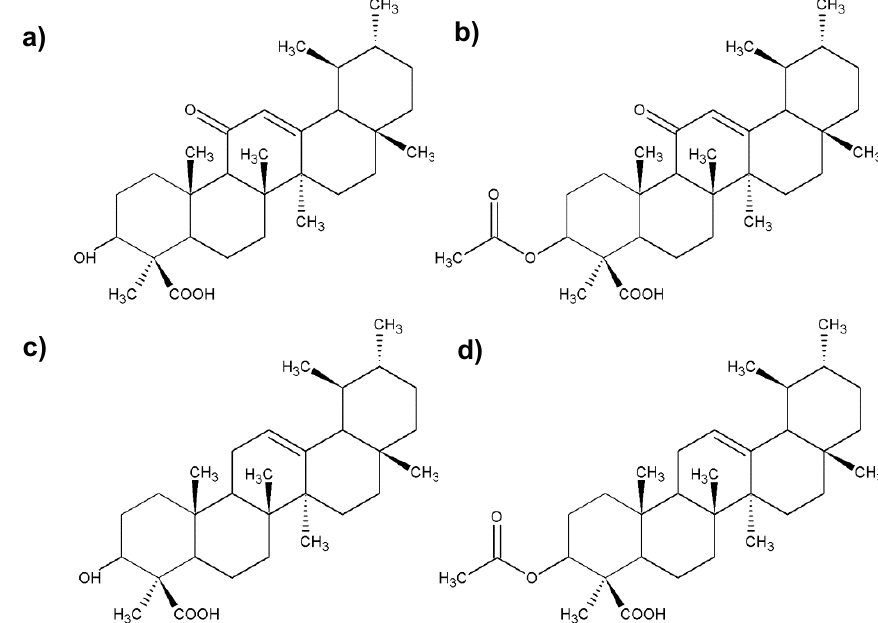
Figure 3. Chemical structure of the most important boswellic acids (BAs); ( a ) 3-O-acetyl-11-keto- β -boswellic acid; ( b ) 11-keto- β -boswellic; ( c ) acetyl- β -boswellic acid; ( d ) β -boswellic acid.